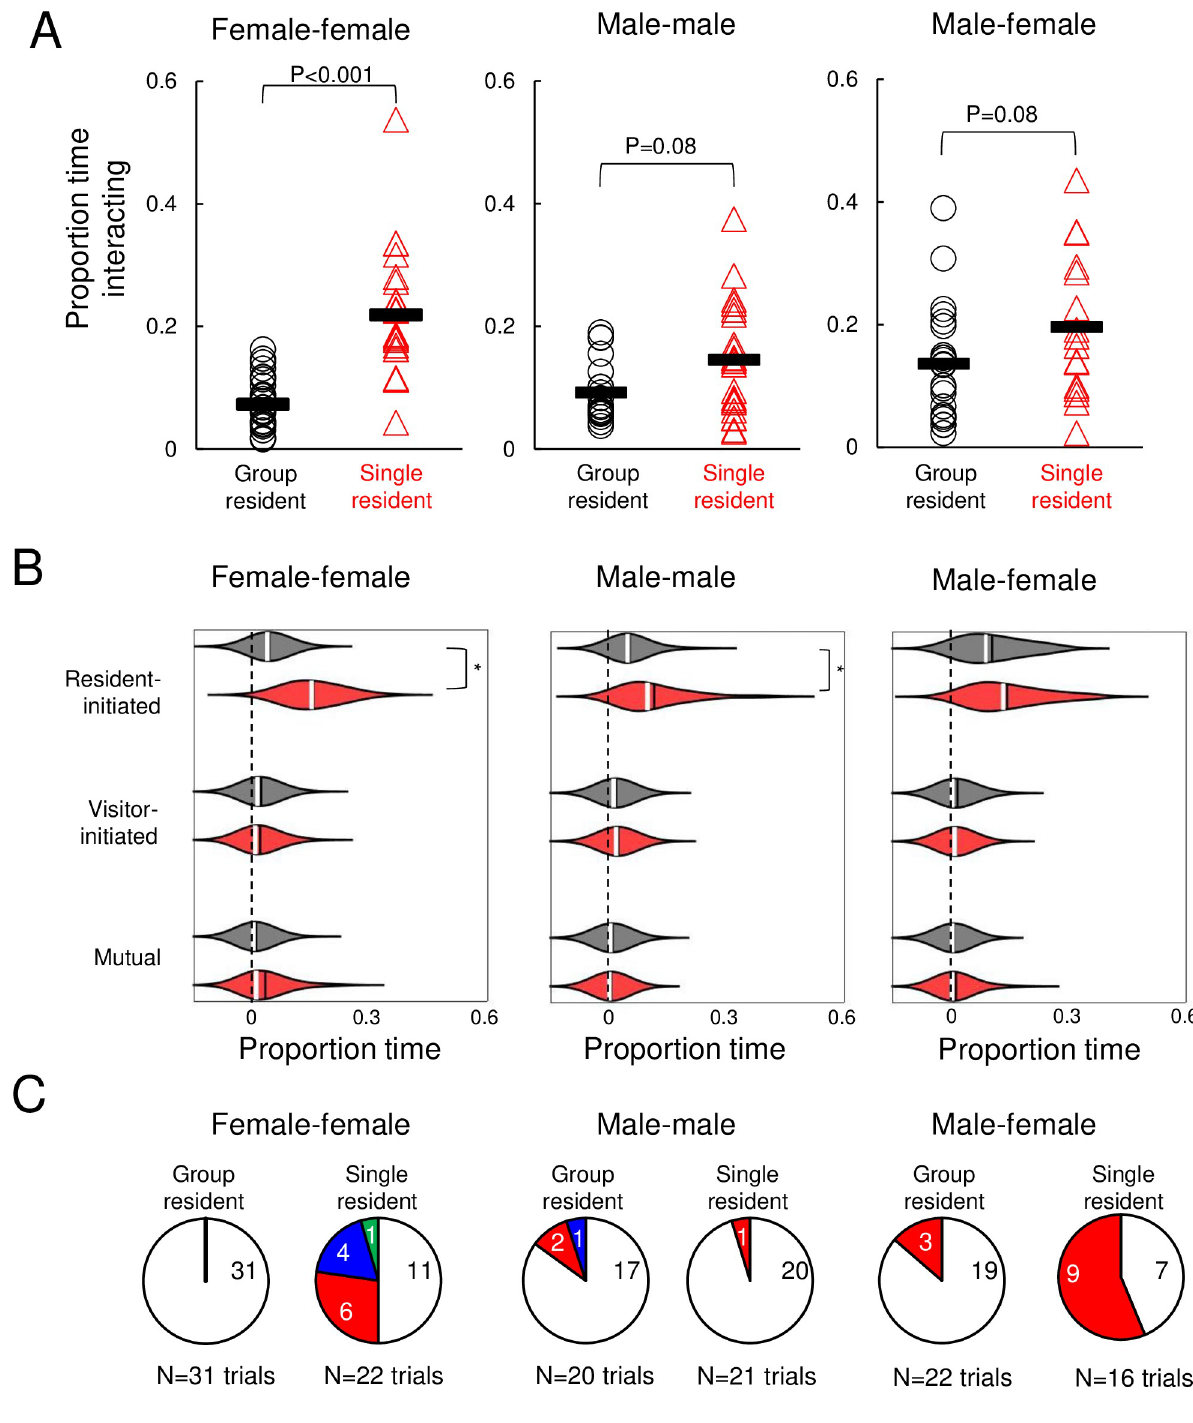
Fig 2. Effects of acute isolation on non-vocal social behaviors. (A) Proportion time spent engaged in social interaction is shown for female-female trials (left), male-male trials (middle), and male-female trials (right). (B) Violin plots show the proportion time spent engaged in different non-vocal social behaviors for female-female trials (left), male-male trials (middle), and male-female trials (right). Gray, trials with group-housed residents; red, trials with single-housed residents. White lines indicate median values, black lines indicate mean values. Asterisks, p < 0.05. (C) Pie charts show the number of trials with mounting in female-female trials (left), male-male trials (middle), and male-female trials (right). White, no mounting; red, resident-initiated mounting; blue, visitor-initiated mounting; green, trials with both resident- and visitor-initiated mounting.